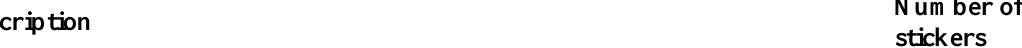
Table A1.1. List of ES used in the workshop and total number of stickers each ES received from participants. ES in bold correspond to selected